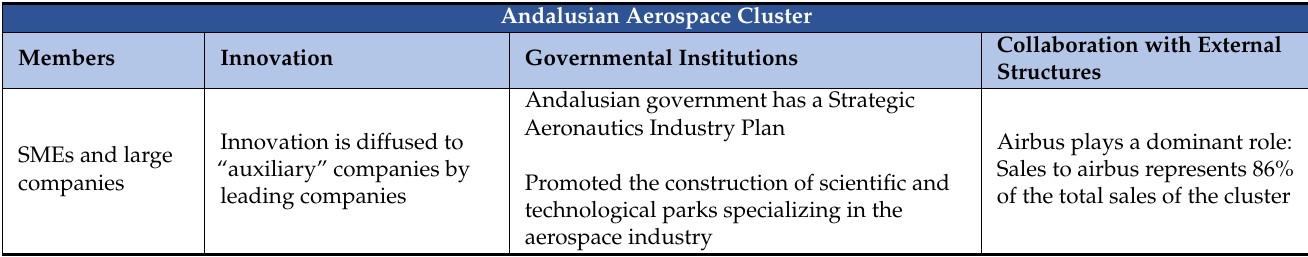
Table 3. Main characteristics of the Andalusian Aerospace Valley, according to Markusen’s